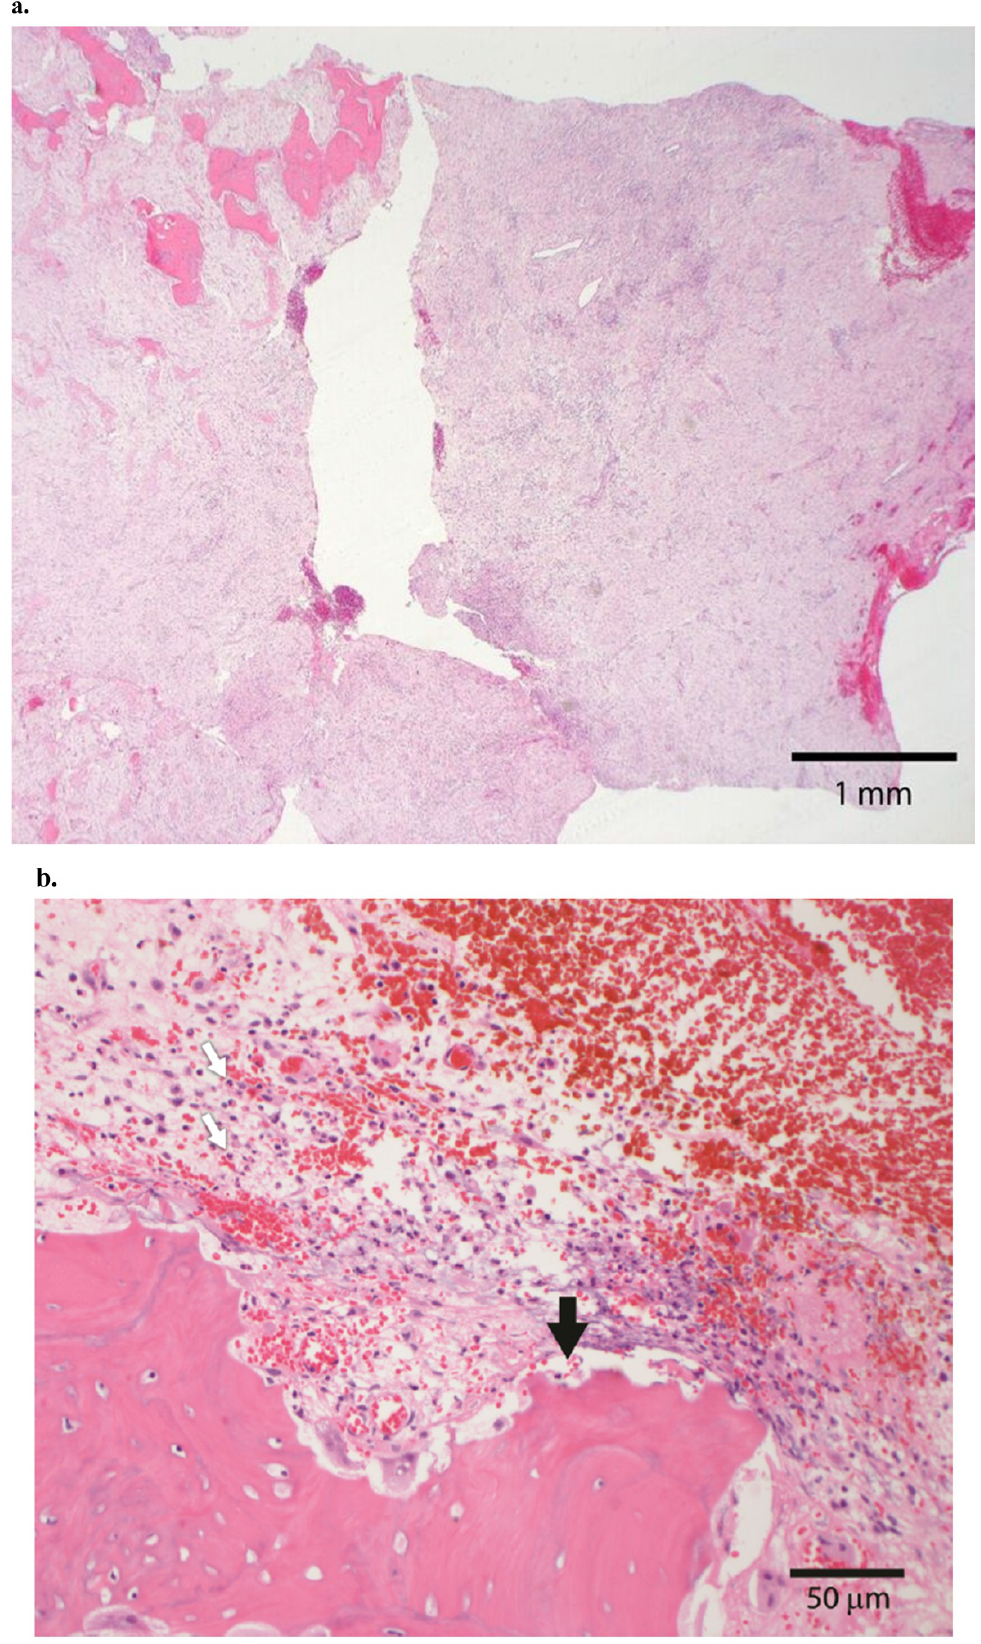
Figure 6. a. The excision specimen consisted of viable lamellar bone (top left) and new woven bone (middle left), entrapped in a fibrous matrix with vascular proliferation and extensive acute and chronic inflammation (20X original magnification). b. At higher magnification, the native lamellar bone shows extensive scalloping (black arrow) associated with a neutrophilic infiltrate (white arrows). The findings support acute osteomyelitis (200X original